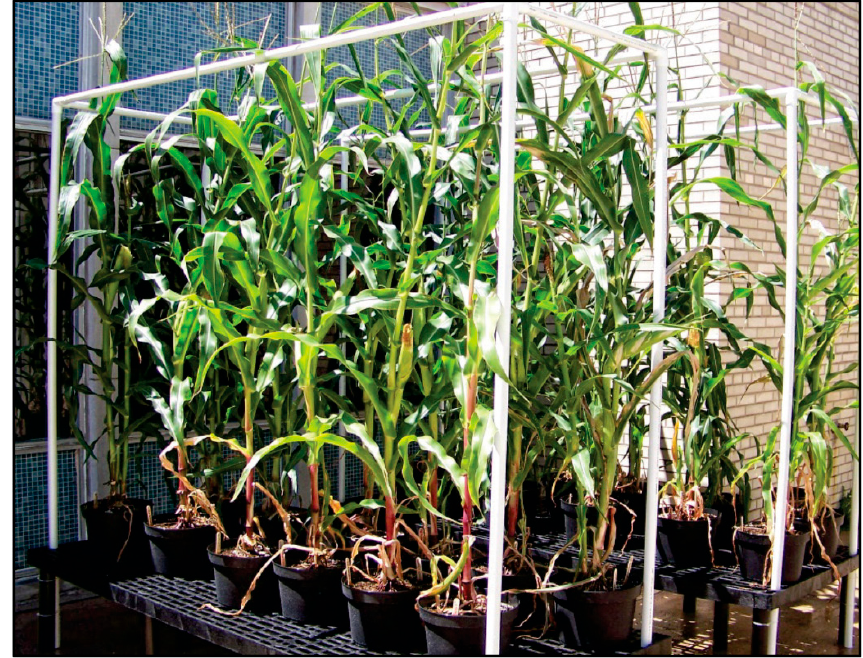
Figure 1. Outdoor potted plant studies. Plants were grown in 2.7 gallon pots in ProMix